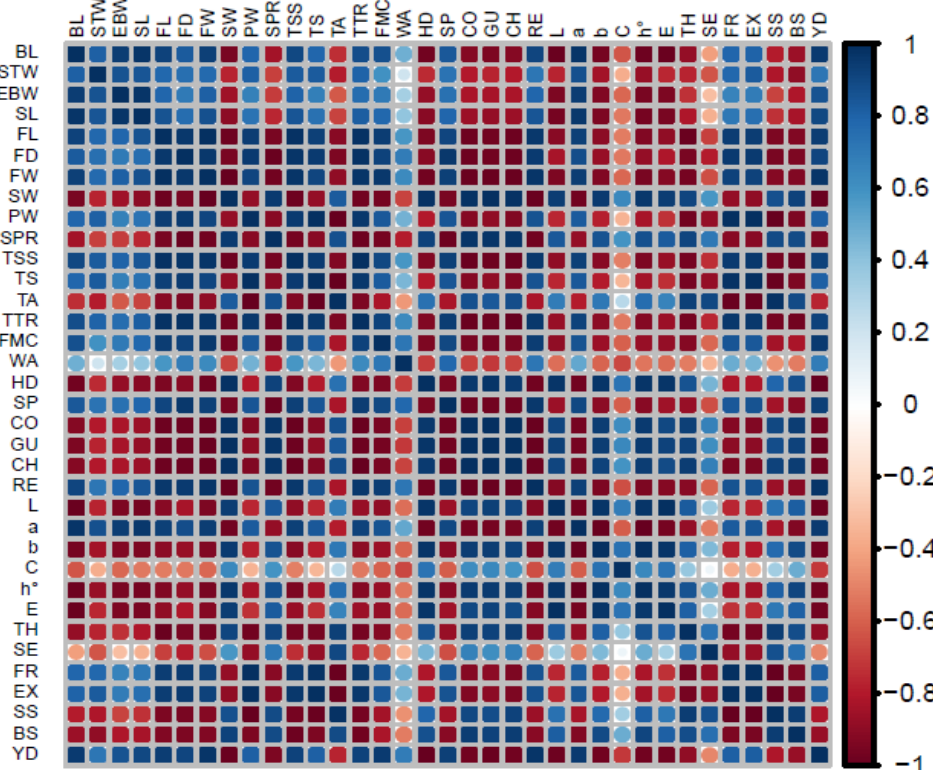
Figure 3. Correlation analysis of bunch and fruit characteristics of date palm cv. Sukary subjected to four irrigation levels, three SOP fertilizer doses, and three bunch thinning levels.